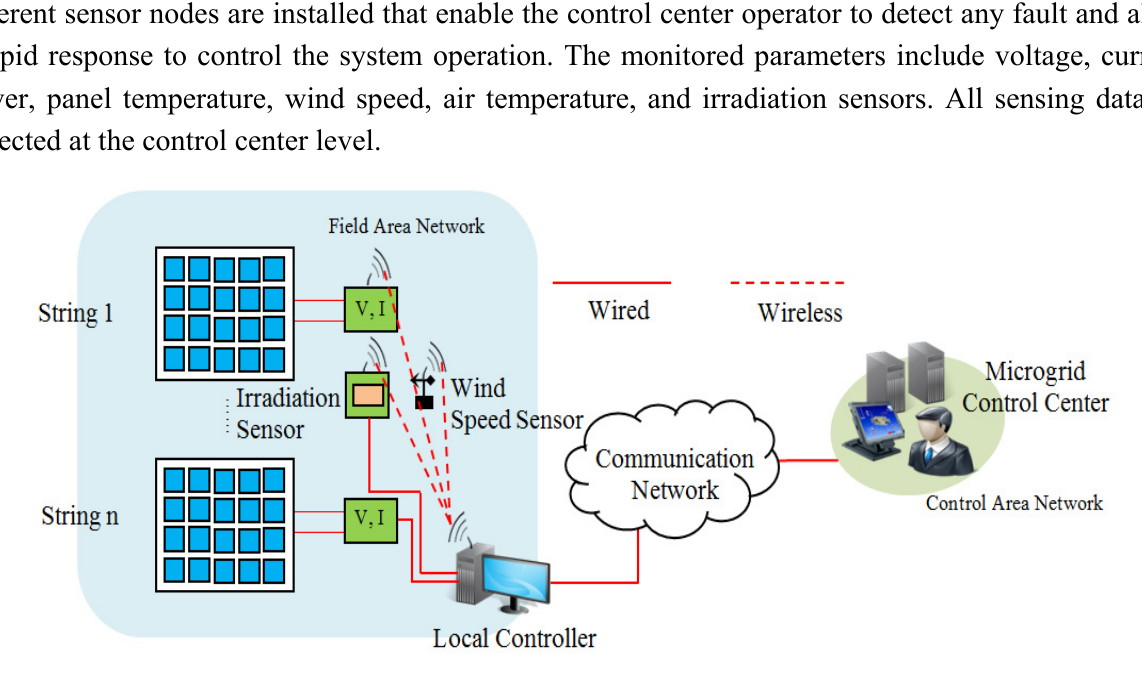
Figure 4. Communication network for a PV